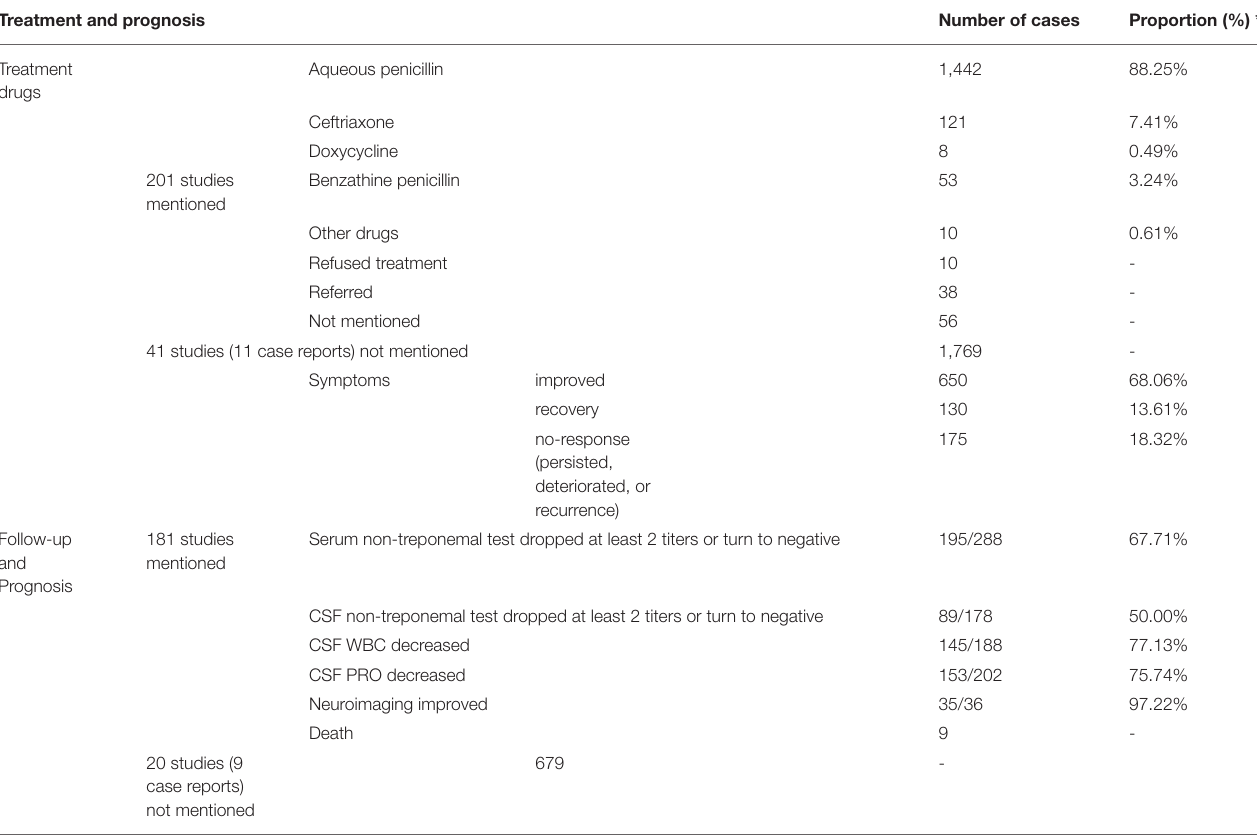
TABLE 3 | The treatment and follow-up of neurosyphilis cases from 149 case reports and 93 retrospective case series. Treatment and